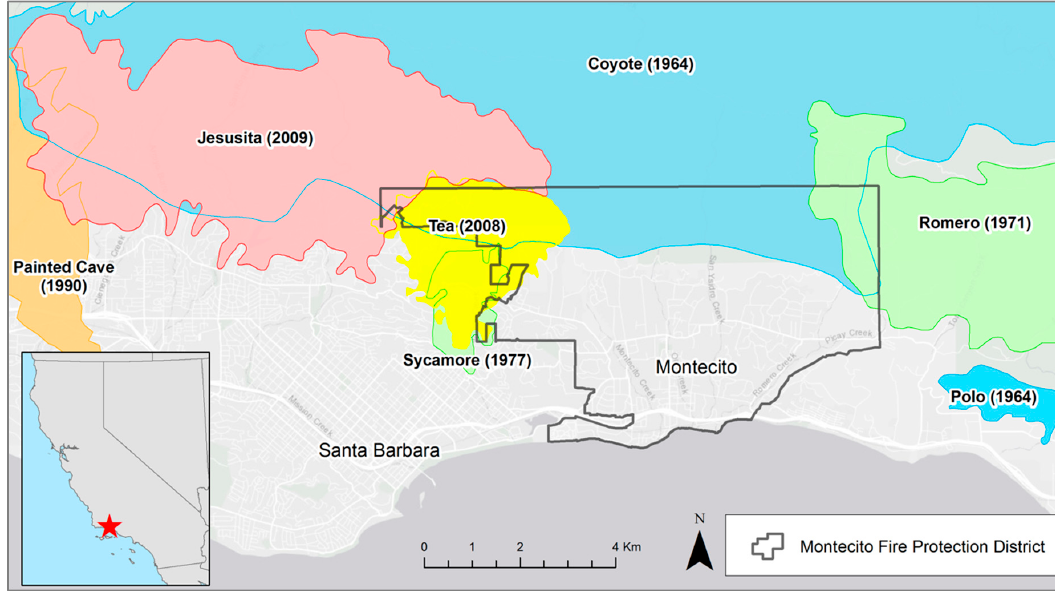
Figure 1. Study area and large fire history 1950–2017 (does not include the Thomas Fire).